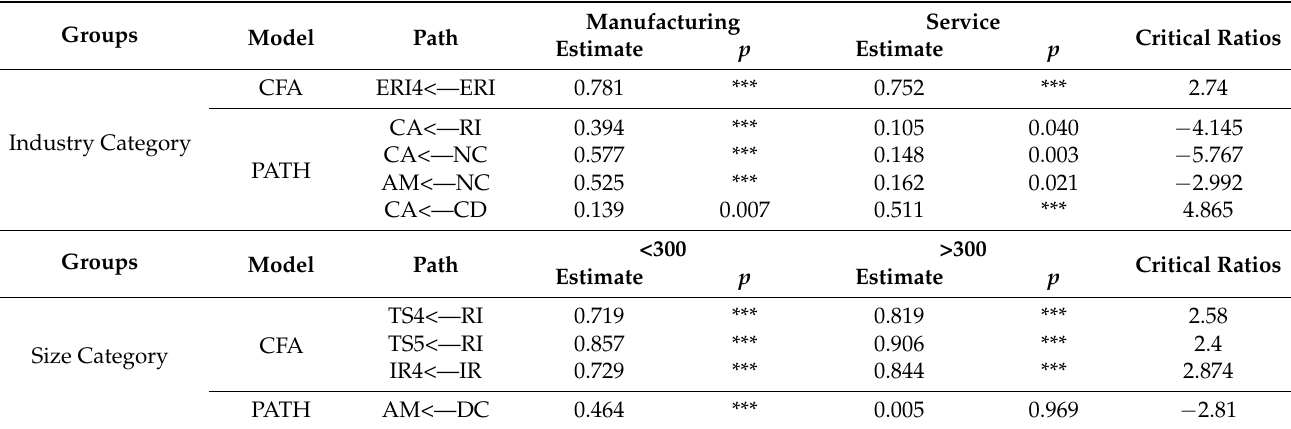
Table 4. The critical ratios of path